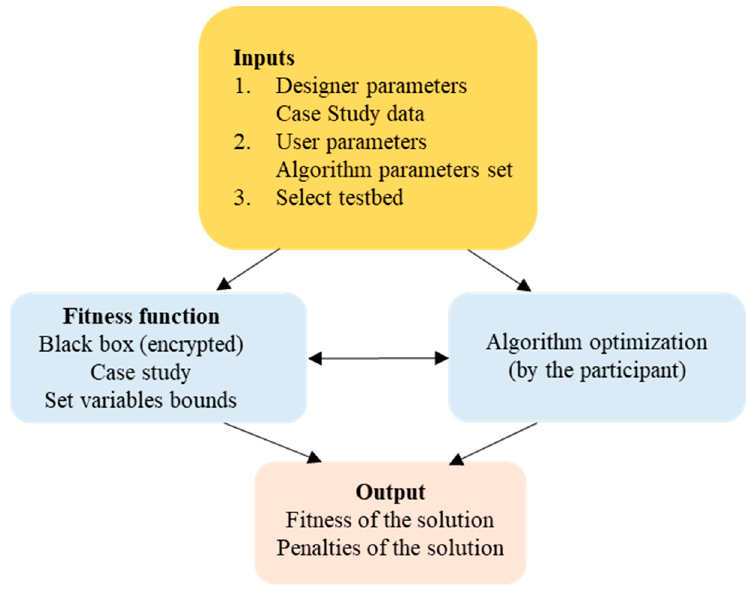
Figure 2. Structure of fitness function.